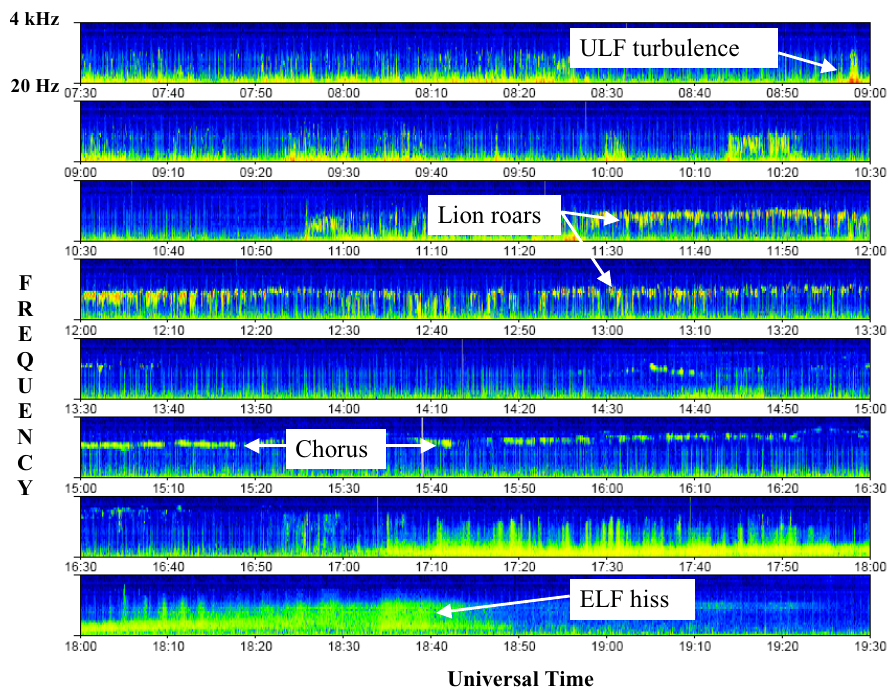
Fig. 6. Details of the spectrum analyser data for the same day as in Fig. 5, 27 March 2004, from 07:30 to 19:30 UT, with a 4-s time resolution, and a logarithmic frequency scale. This is an example of the different kinds of waves that can be observed on a dayside orbit of DSP TC1, here from the solar wind to perigee. ULF turbulence is observed at bow shock crossings, lion roars inside the magnetosheath, chorus and hiss in the inner